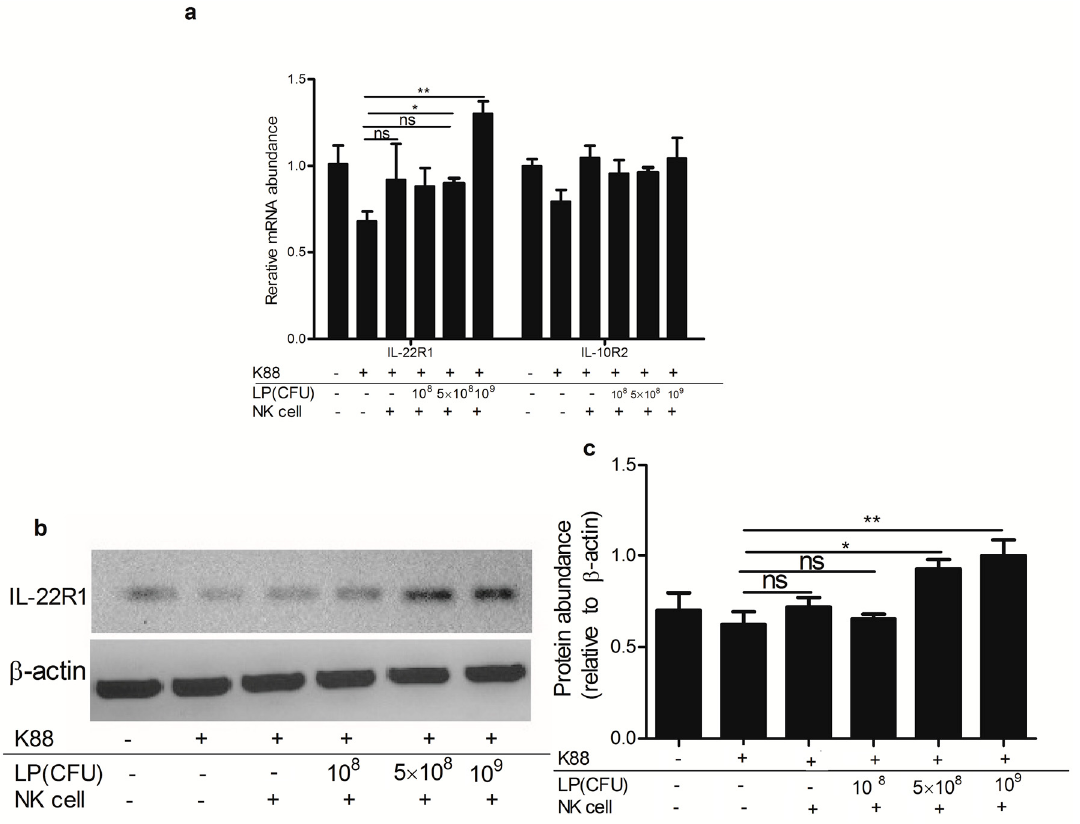
Figure 6. NK cells stimulated by Lactobacillus plantarum (LP) increased the expression of IL-22 receptor in ETEC K88-infected NCM460 cells. NCM460 cell monolayers were untreated or treated with 10 8 CFU/mL ETEC K88 for 2 h, then NK cells stimulated or not by LP (10 8 , 5 × 10 8 or 10 9 CFU/mL) were added to ETEC K88-infected NCM460 cells and co-cultured for another 4 h. After treatments, NCM460 cells were collected and the expressions of IL-22R1 and IL-10R2 were analyzed. ( a ) The abundance of IL-22R1 and IL-10R2 mRNA; ( b ) The protein level of IL-22R1 was determined by Western blotting. Equal protein loading was confirmed by analysis of β -actin in the protein extracts; ( c ) The ratios of IL-22R1 to β -actin. Similar results were obtained from 3 independent experiments. Data are means ± SEM. * p < 0.05, ** p < 0.01, ns: not significant.